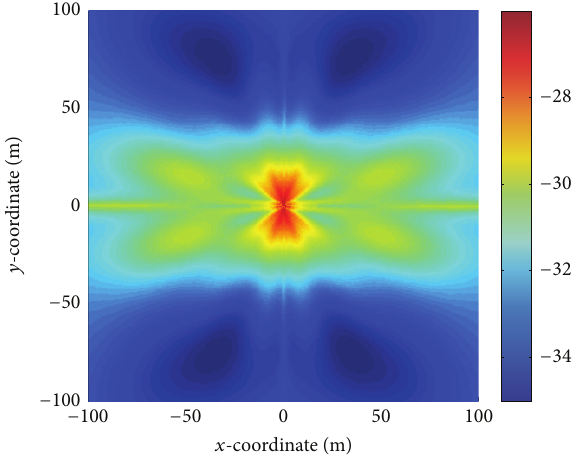
Figure 21: Average power of received echo signals (in dB relative to LOS) depending on the relative horizontal position of the corresponding estimated reflection point in the urban city center environment at 20 ∘